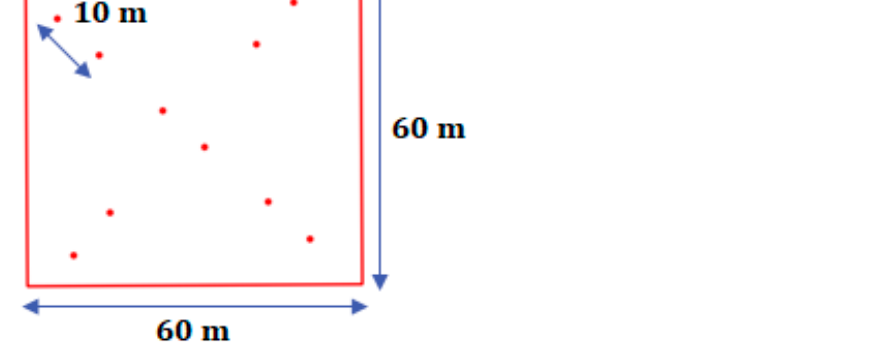
Figure 2. Sketch of the ground-based measurements describing the ESU defined for the Pignola field campaign.